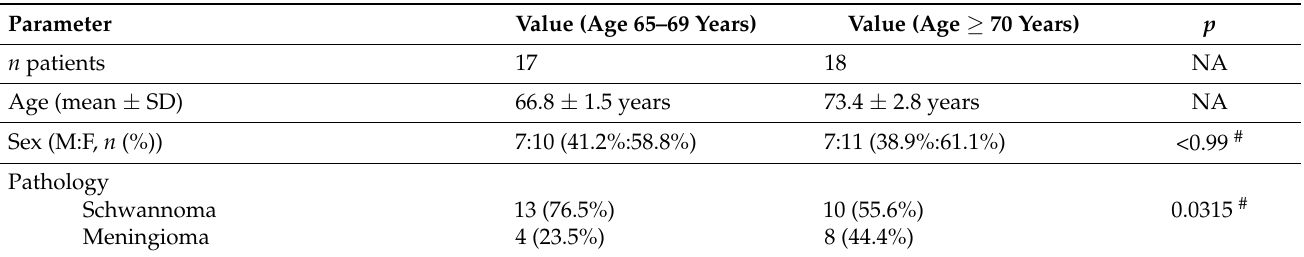
Table 1. Patients’